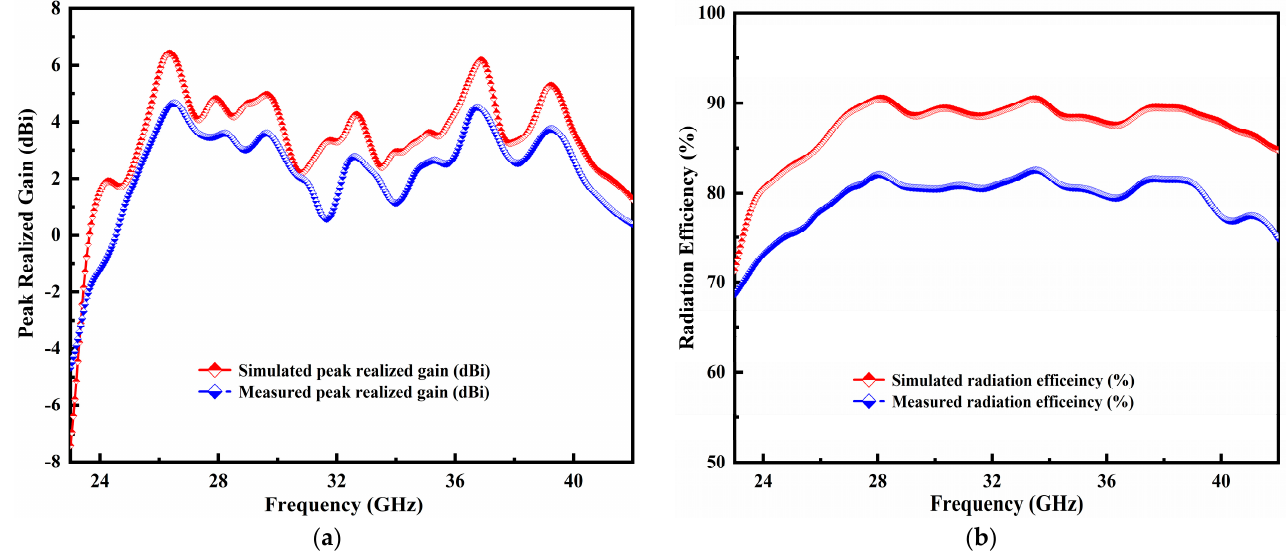
Figure 10. Simulation and measurement results of peak realized gain and radiation efficiency in the entire frequency